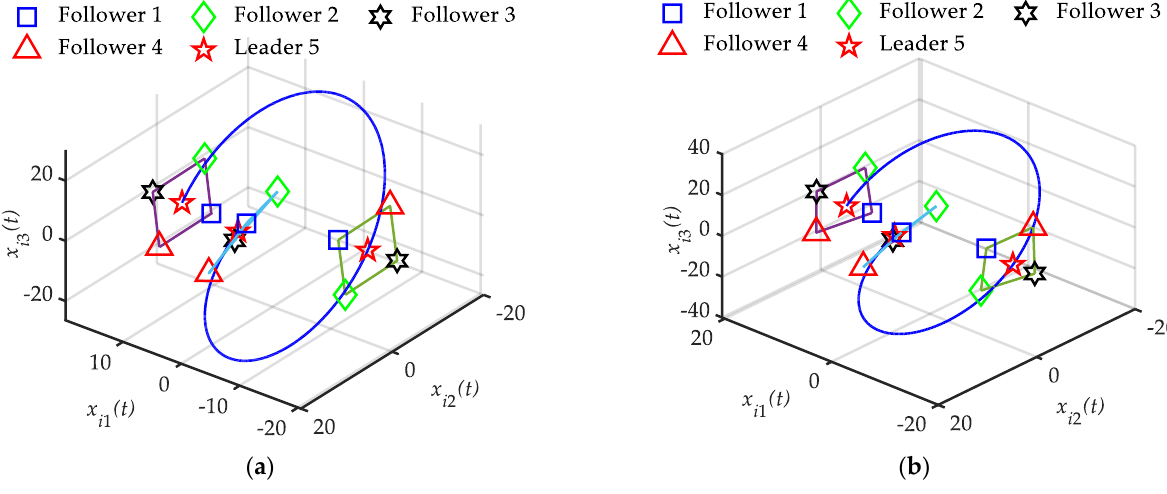
Figure 7. Formation tracking position trajectories and snapshots at different time instants of four followers and one leader. ( a ) Current approach; ( b ) Previous Approach [24].